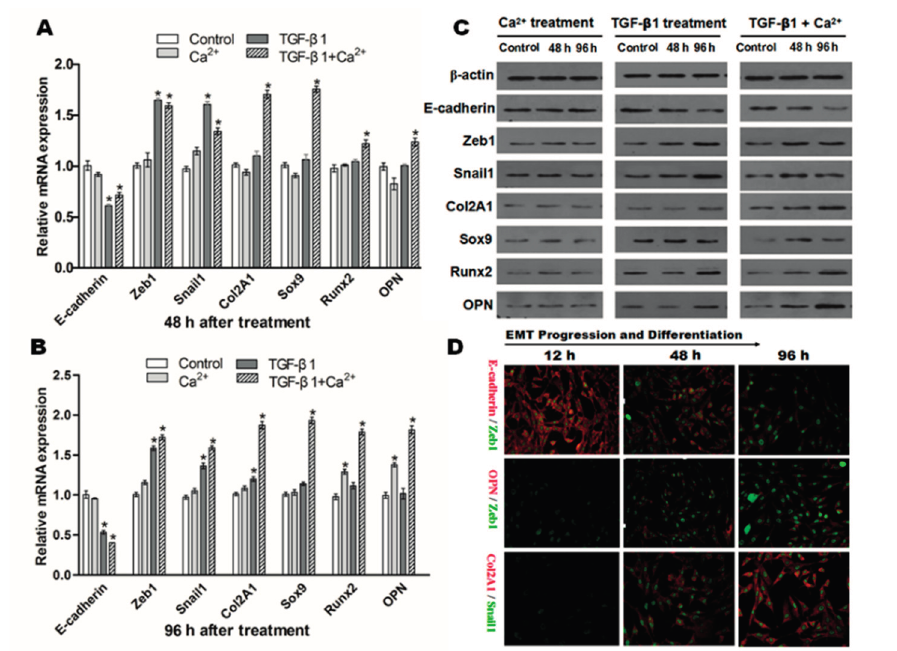
Figure 8. NRK cells induced by TGF- β 1, Ca 2+ or both lead to different